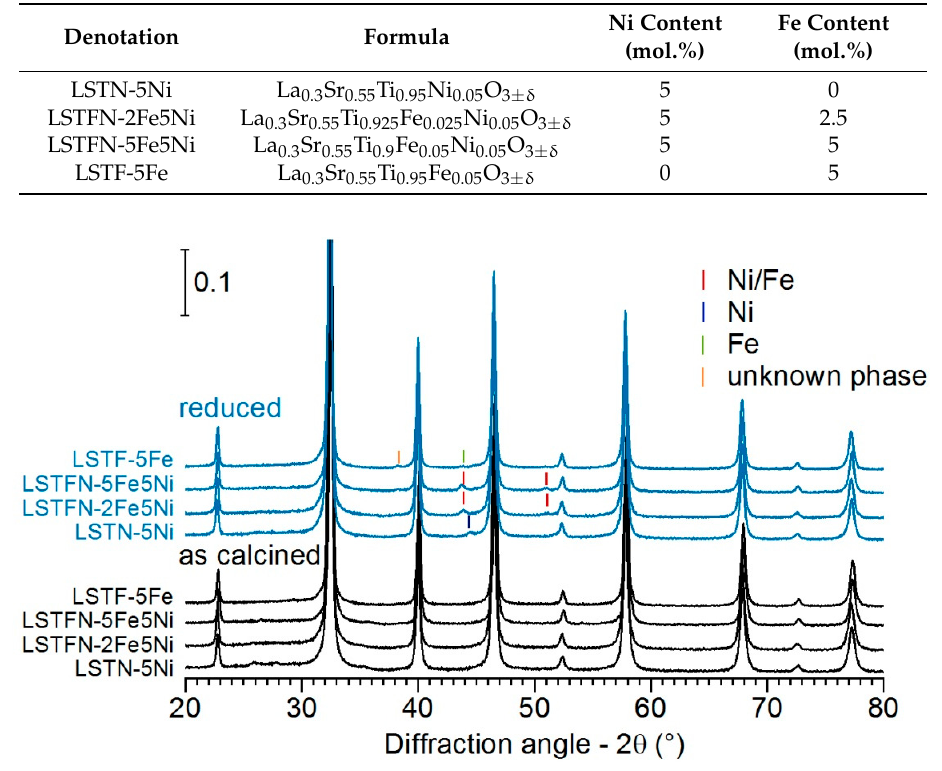
Figure 5. Powder XRD patterns of calcined and reduced LSTN-5Ni, LSTFN-2Fe5Ni, LSTFN-5Fe5Ni and LSTF-5Fe (10 vol% H 2 /Ar, 800 °C, 15 h). Diffractograms are magnified with respect to intensity (2×) to emphasize Ni, Fe and Ni/Fe reflections.